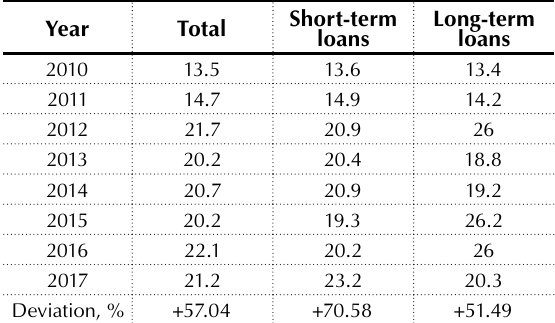
Table 1. Interest on loans in hryvnia according to the statistical reporting of Ukrainian banks (excluding overdraft) in 2010–2017